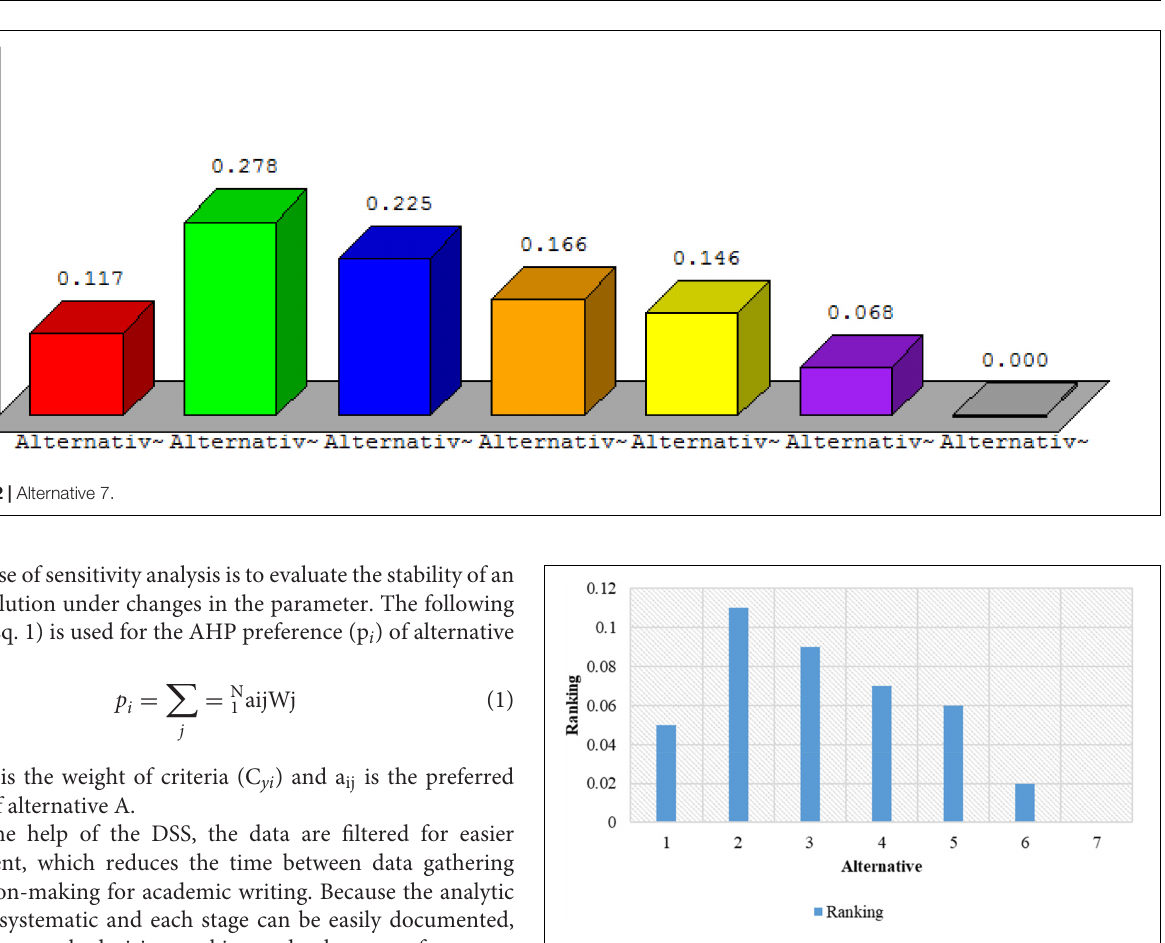
FIGURE 11 | Alternative 6.